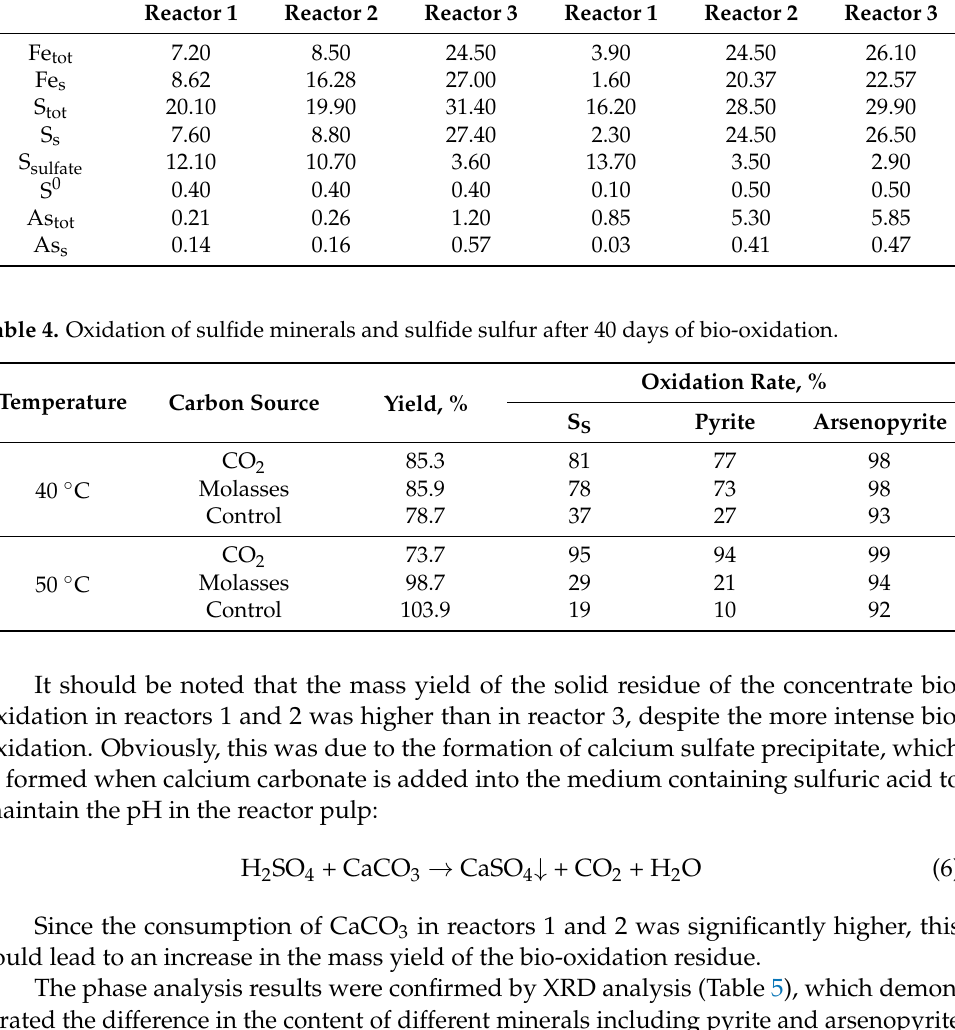
Table 3. Chemical composition of bio-oxidation residues.